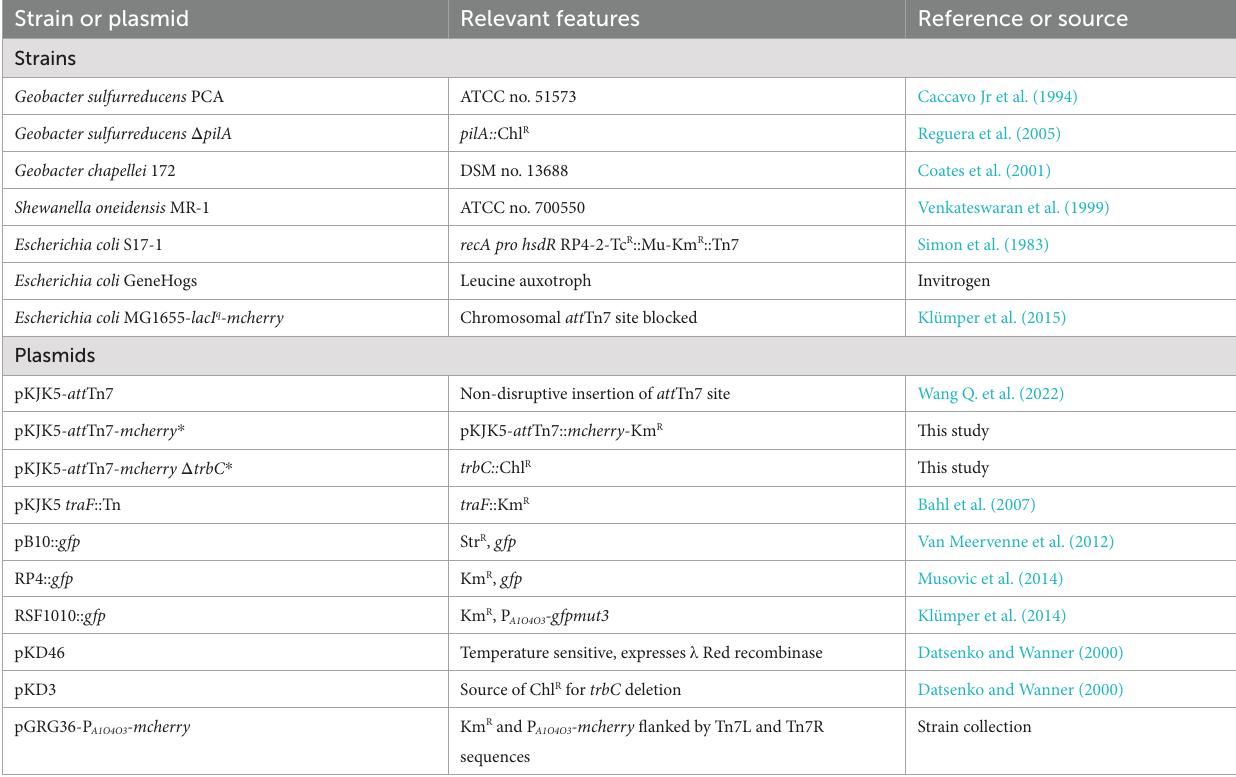
TABLE 1 Strains and plasmids used in this